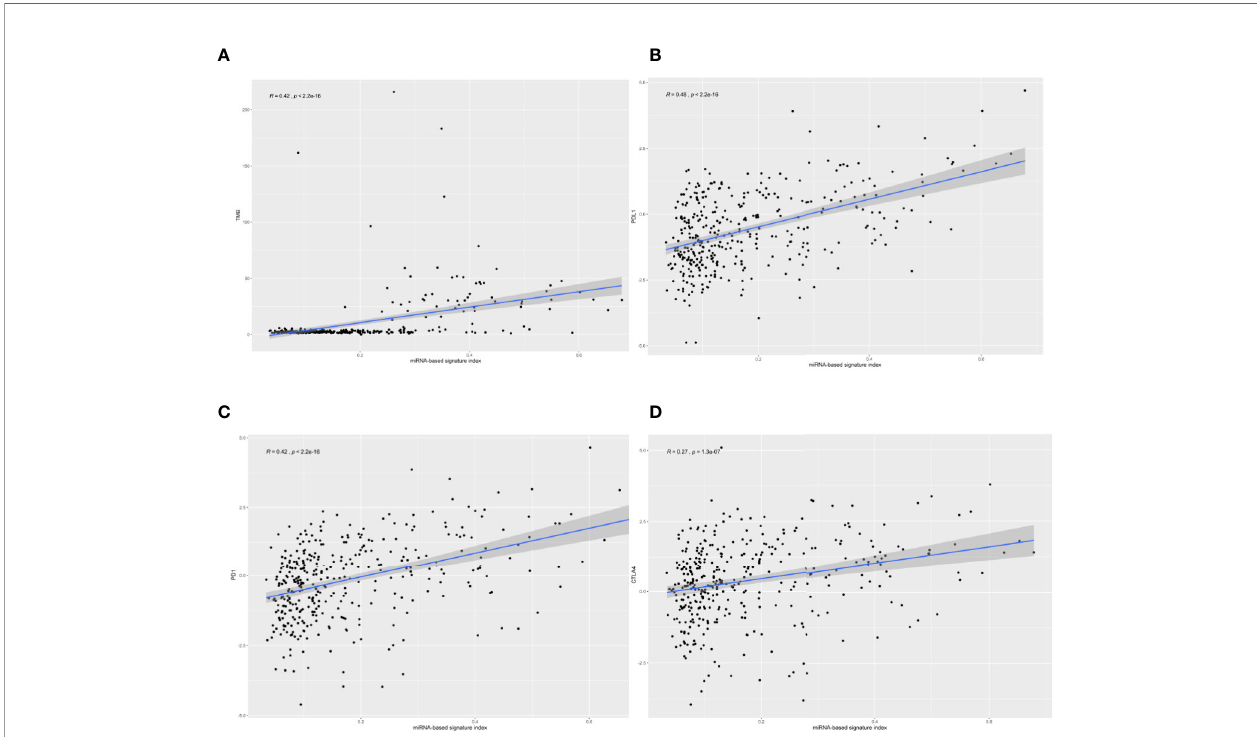
FIGURE 3 | The correlation of four-microRNA (miRNA)-based signature index with tumor mutational burden (TMB), PD-L1, PD-1, and CTLA-4. The four-miRNA- based signature index is (A) correlation with TMB; (B) low correlation with PD-L1 expression; (C) low correlation with PD-1 expression, and (D) no correlation with CTLA4 expression.